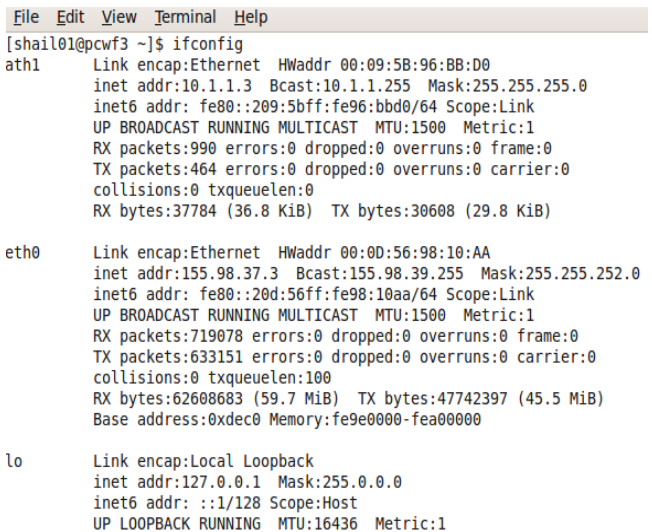
Fig. 19: Configuration details at remote node in wireless experiment